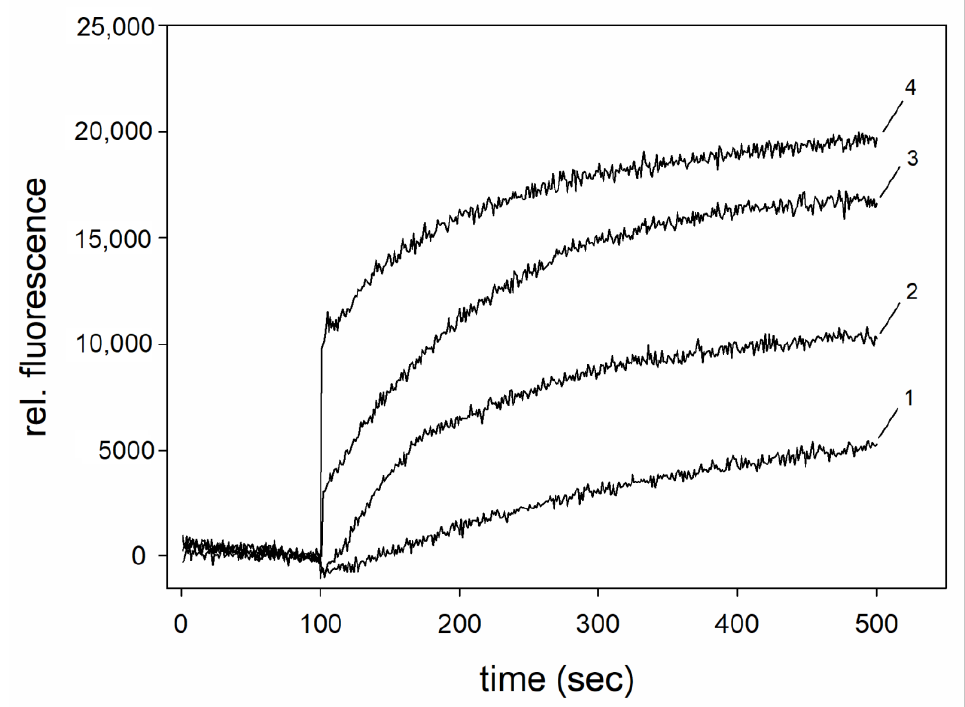
Figure 3. Functional test of the G t α /Gi α chimera. G t α /Gi α was present at 1 µ M in fluorescence buffer. Trp fluorescence emission recording after injection of 50 µ M AlF 4 − . Different MgCl 2 concentrations were present in fluorescence buffer, as indicated, and resulted in a successive increase in relative fluorescence emission: (1) zero extra addition of MgCl 2 in buffer, very small amount of MgCl 2 present after the purification procedure; (2) 100 µ M (2); 500 µ M (3); 1000 µ M (4).